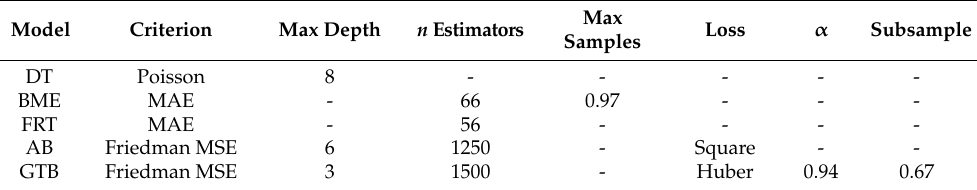
Table 4. Hyperparameters for each